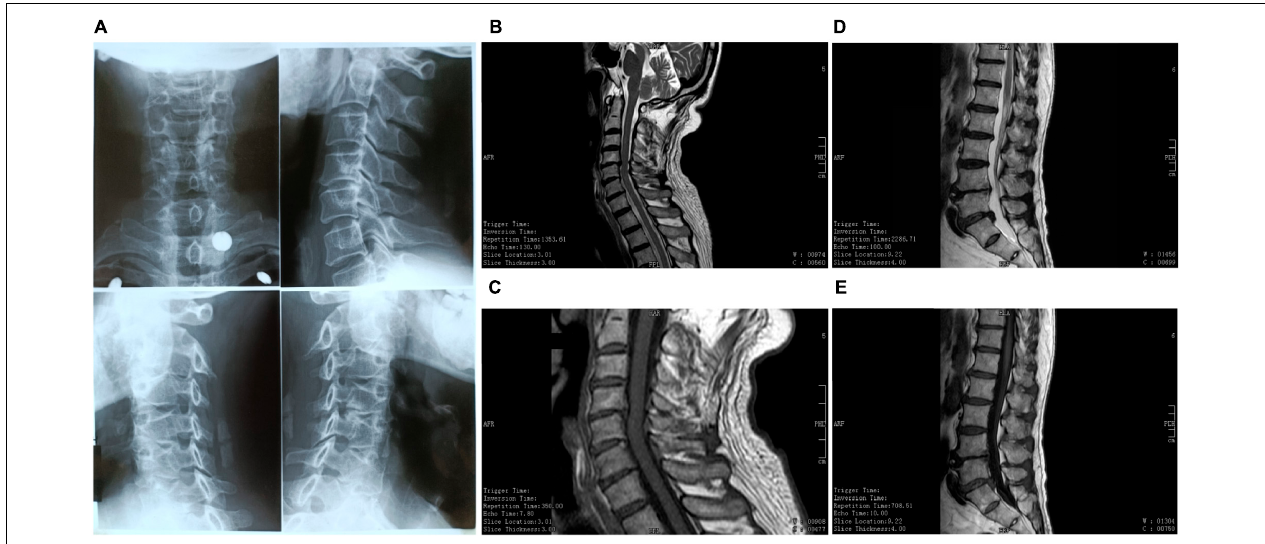
FIGURE 4 | Spine. (A) Cervical X-ray examination in 2002. At that time, he was diagnosed with cervical degeneration and narrowing of the intervertebral foramen and intervertebral space. (B,C) Cervical magnetic resonance imaging (MRI) scan in 2020. (D,E) Lumbar MRI in